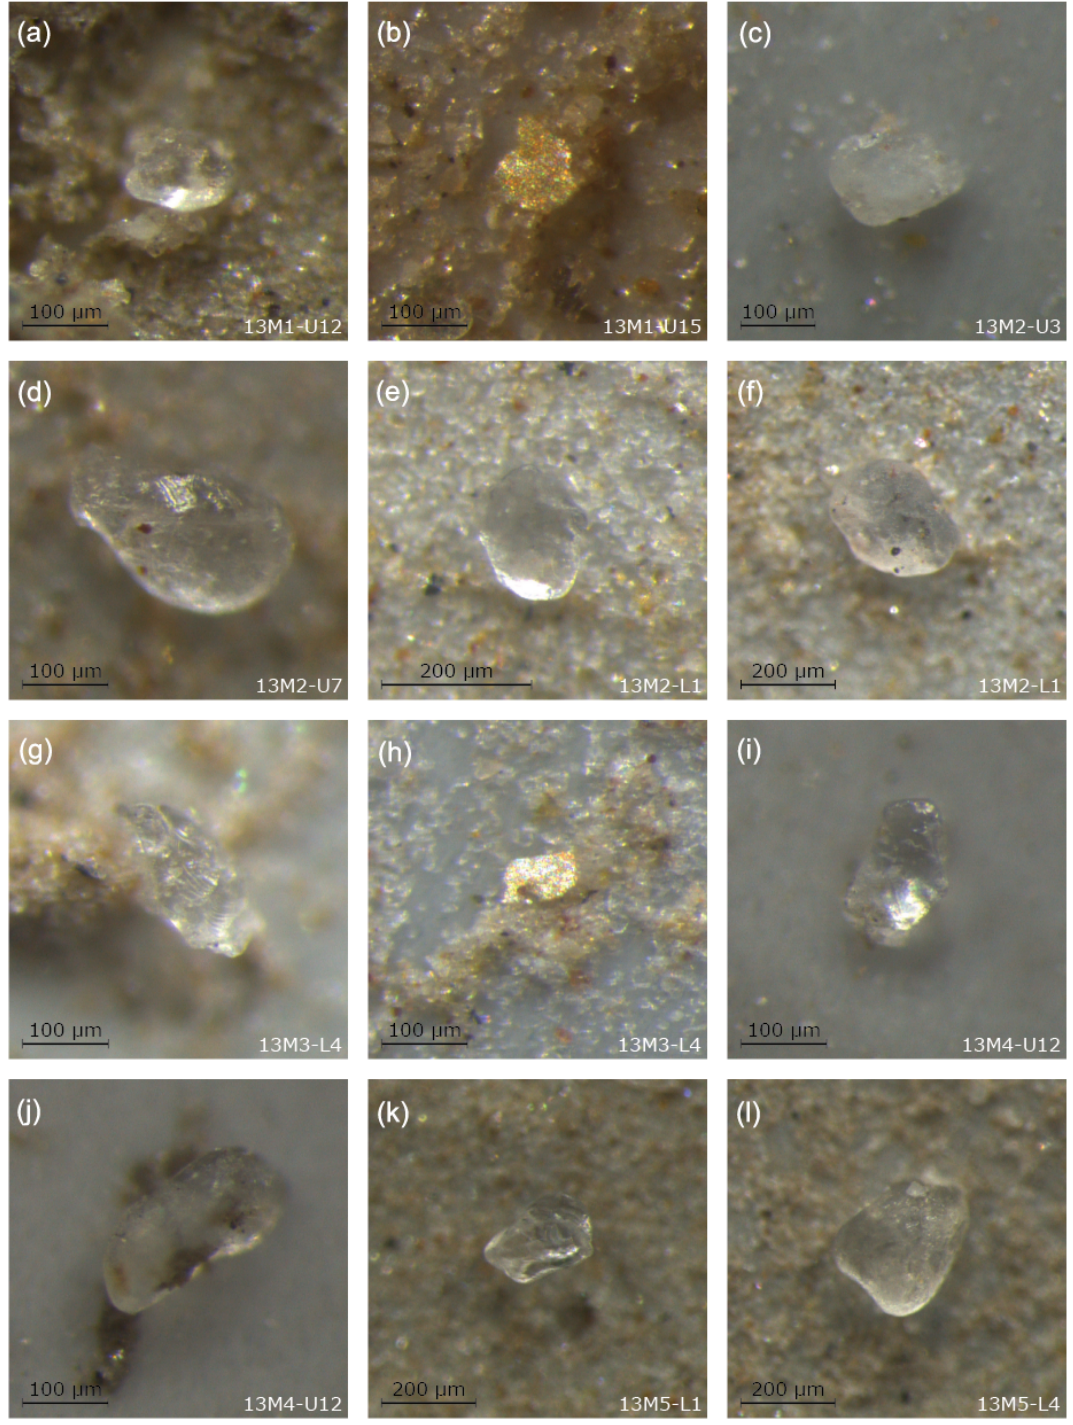
Figure 5. Light-microscope images of large dust particles from the sediment-trap samples. Names in the lower-right corners: 13Mx denotes the station (see Table 1 for the exact locations). U and L denote upper (1200m) and lower (3500m) traps, respectively, followed by the sample number (out of a total of 24). (a) Quartz particle (diameter approximately 140µm), (b) mica particle (120µm), (c) quartz particle (180µm), (d) quartz particle (270µm), (e) quartz particle (180µm), (f) quartz particle (290µm), (g) quartz particle (200µm), (h) mica particle (85µm), (i) quartz particle (180µm), (j) quartz particle (250µm), (k) quartz particle (240µm), and (l) quartz particle